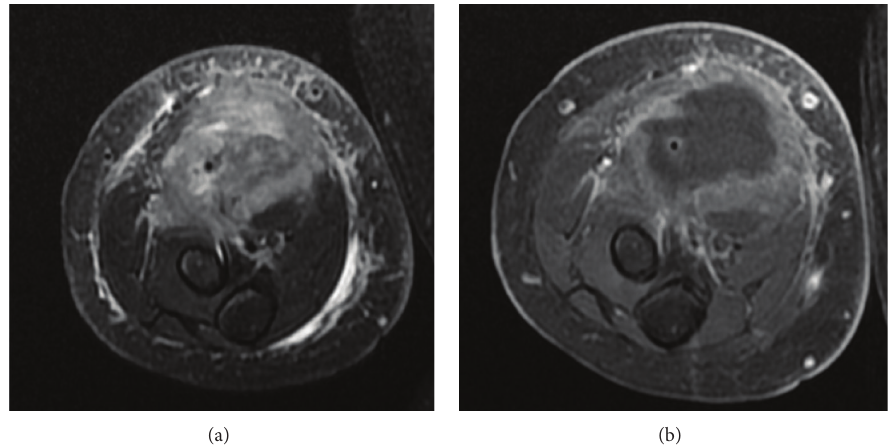
Figure 2: (a) Fat-saturated T2 weighted axial image of the right forearm mass demonstrates a hyperintense lesion within the anterior compartment with edema within the adjacent subcutaneous fat and muscle. (b) Contrast enhanced fat-saturated T1 weighted images of the same level demonstrate irregular peripheral enhancement of the